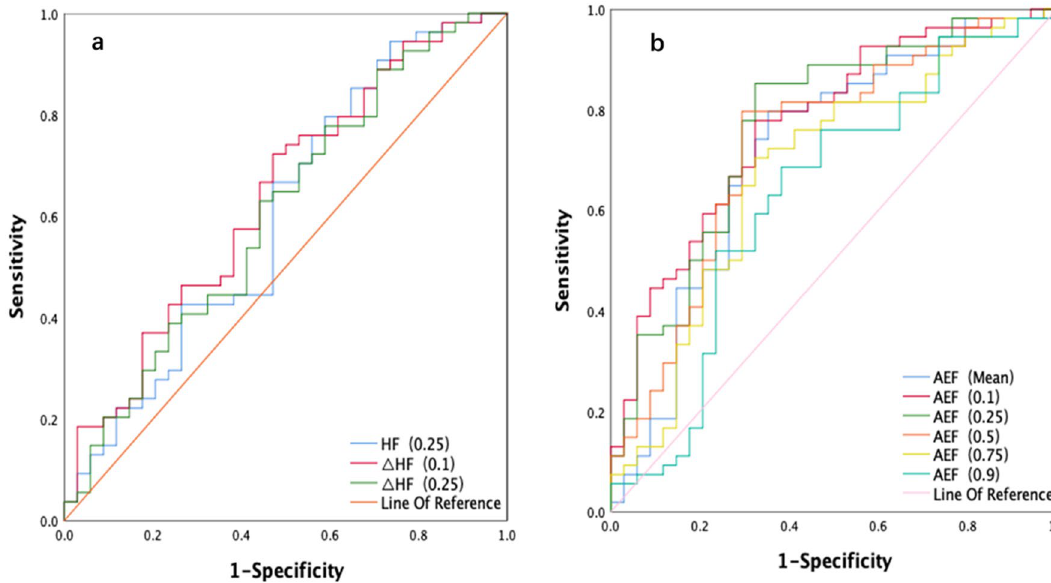
Figure 3. The ROC analysis of HF, AEF, and corresponding percentiles of the parameters for IMCC and HCC (3a and 3b). HF Hepatic blood flow, AEF Arterial enhancement fraction, ROC Receiver operating characteristic, IMCC Intrahepatic mass-forming cholangiocarcinoma, HCC Hepatocellular